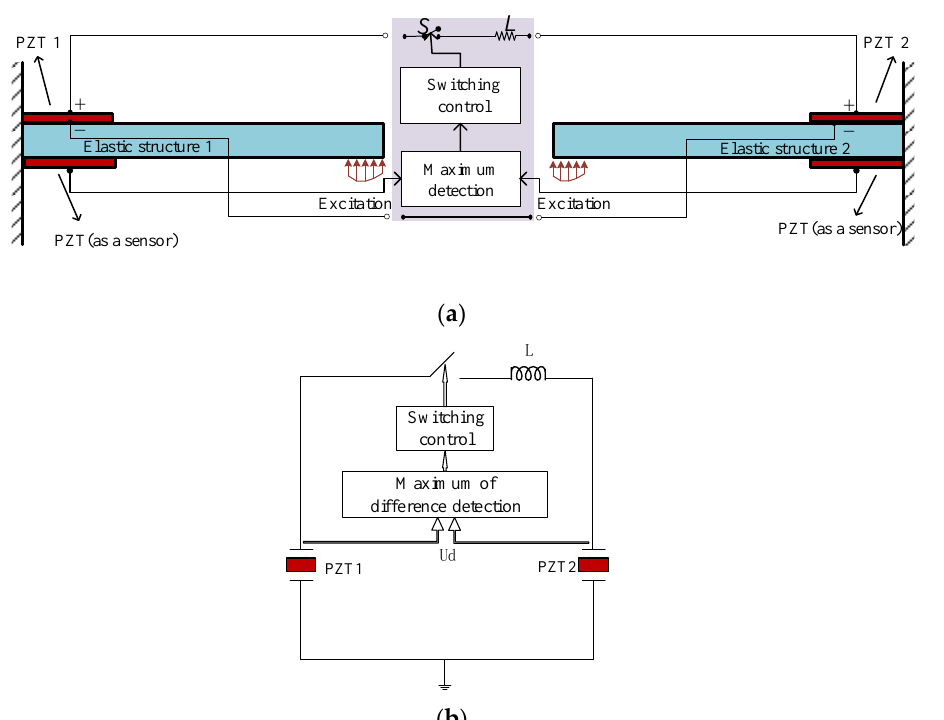
Figure 3. Configuration of the double-beam system with SSDI network: ( a ) model of the double-beam system with SSDI network; ( b ) the equivalent circuit of an SSDI network.